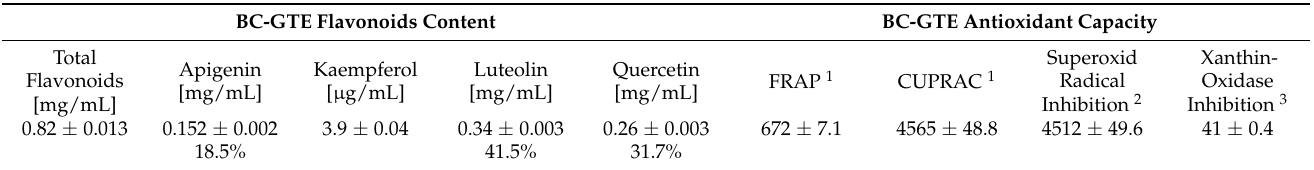
Table 2. BC-GTE flavonoid content and antioxidant